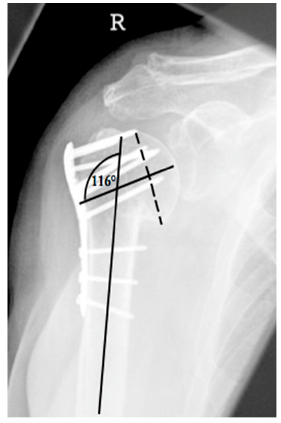
Figure 9. Complication Type 2a. CCD-relative varus displacement of 19°.